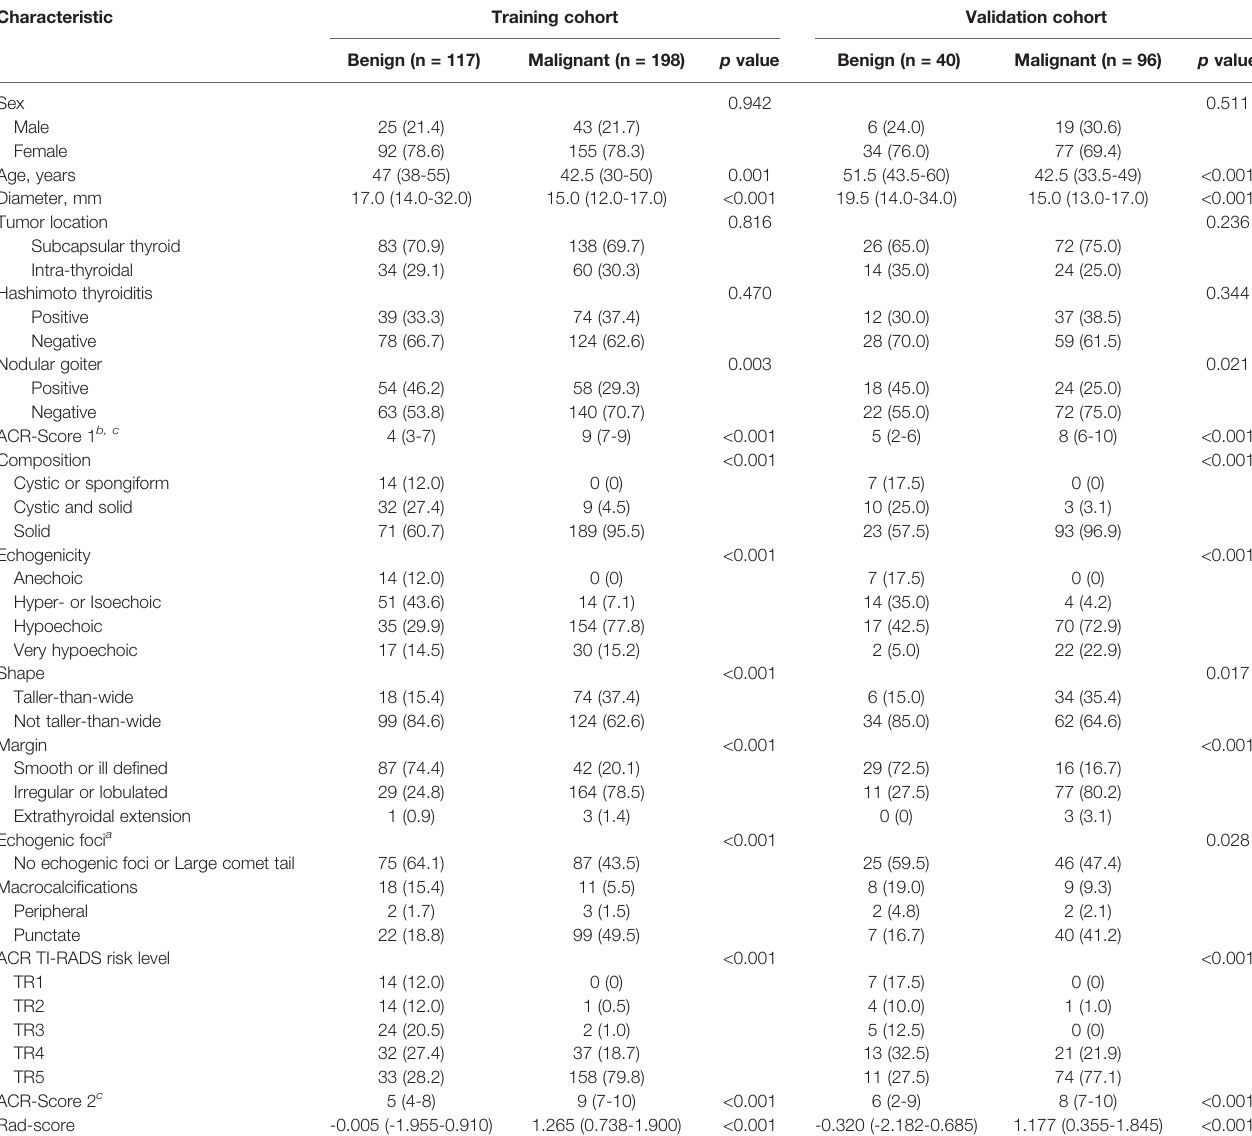
TABLE 2 | Clinicopathological and ultrasonic characteristics for thyroid nodules in the training and validation cohorts by pathology. Characteristic Training